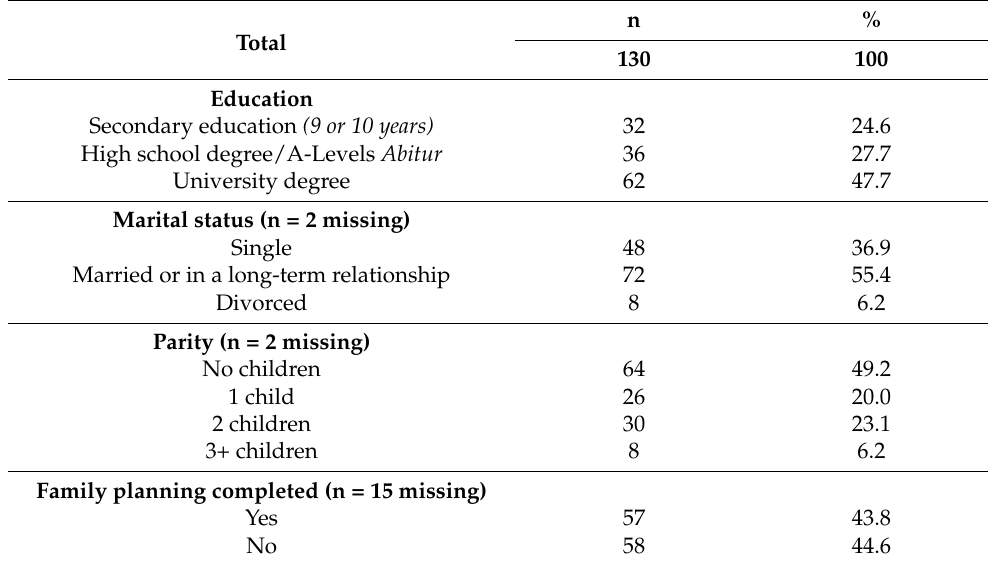
Table 1. Demographic frequencies in the